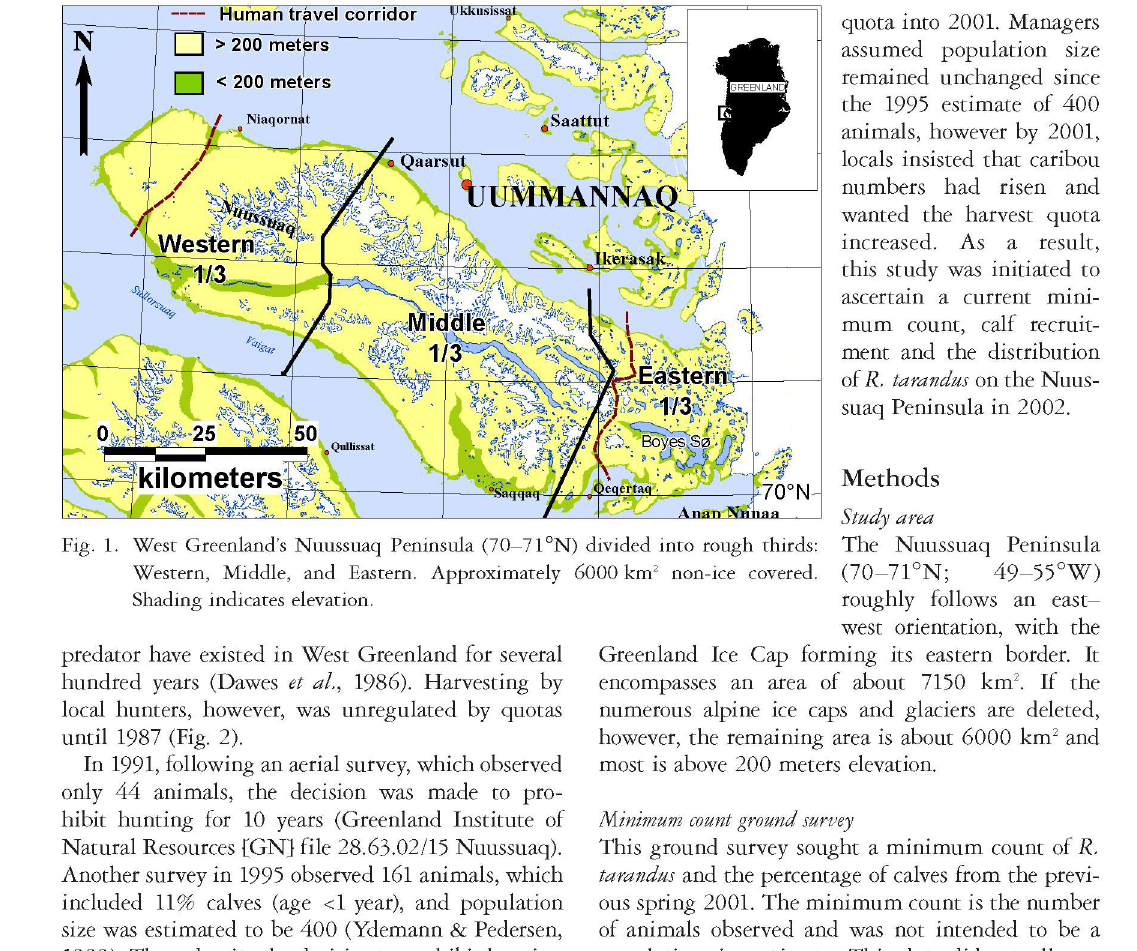
Table 1. Late winter R. tarandus herd structure obser